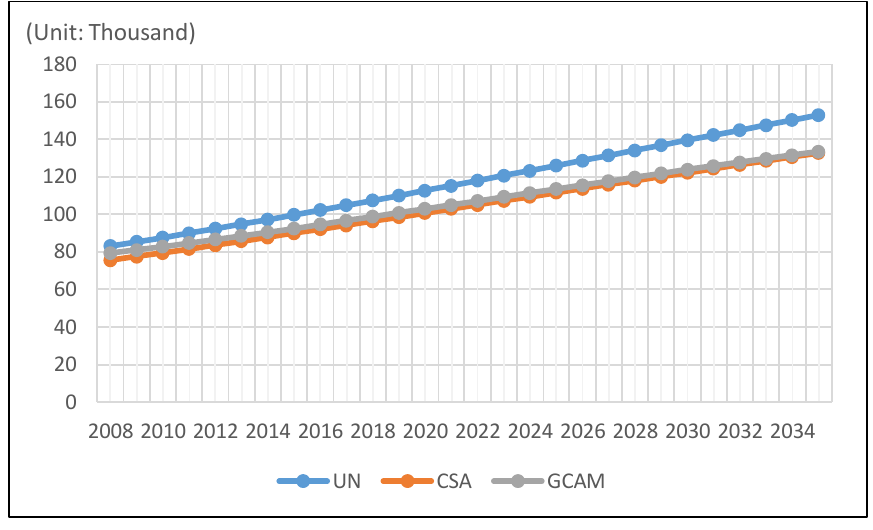
Figure 2. Population information in GCAM.